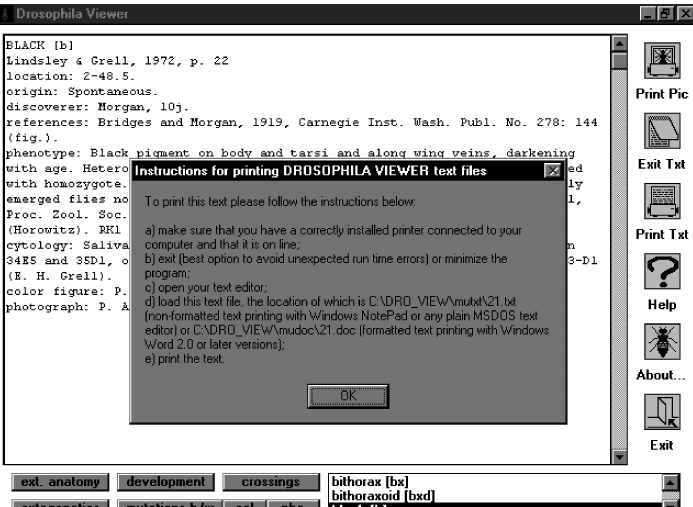
Figure 11 - Sample text obtained by clicking the figure “Text...” [when clicked, the figure’s label toggles to “Exit t(e)xt”]. The text corresponds to the item selected from the mutations option list shown at the bottom left.